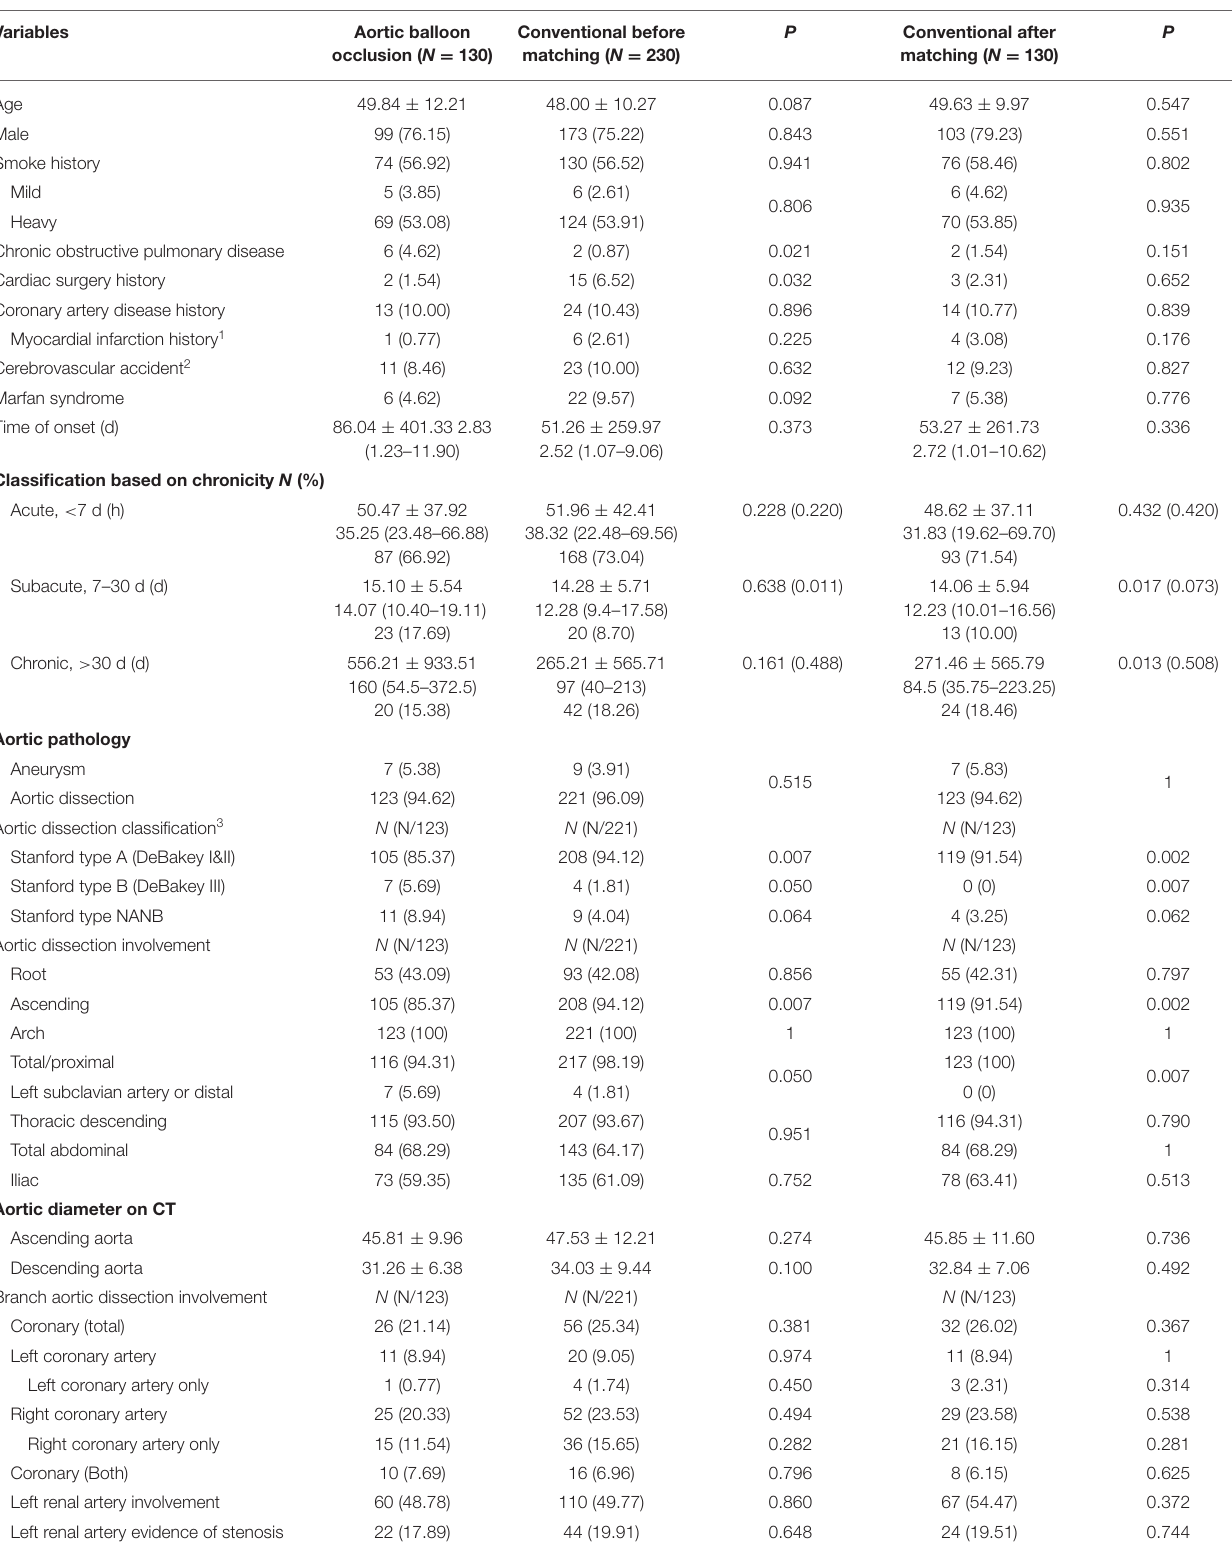
TABLE 1 | Preoperative and operative